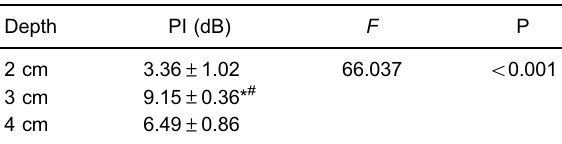
Table 1. Comparison of peak intensity (PI) at different depths beneath the liver capsule.